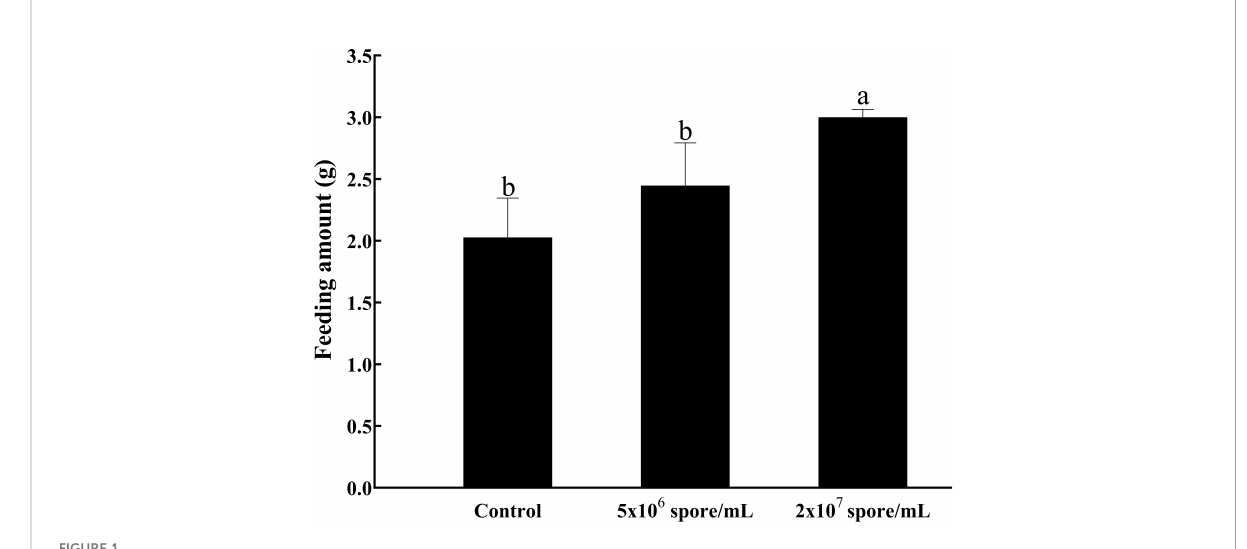
FIGURE 1 Weight (g) of food consumed by L. manilensis after infection with P. locustae . Average daily food intake of adult females on days 1 – 4 after eclosion. Each value is presented as mean ± SD, and different letters indicate signi fi cant differences among different treatments (one-way ANOVA followed by Tukey ’ s multiple comparisons test, P <